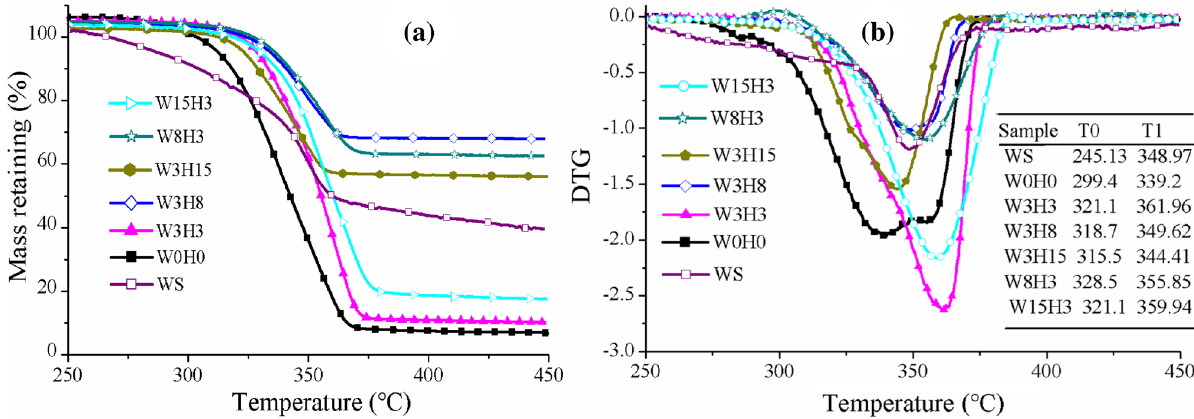
Figure 5. TG curve ( a ) and DTG curve ( b ) of PLA/WS/HA composites: T0, onset temperature of degradation, T1, temperature at maximum degradation